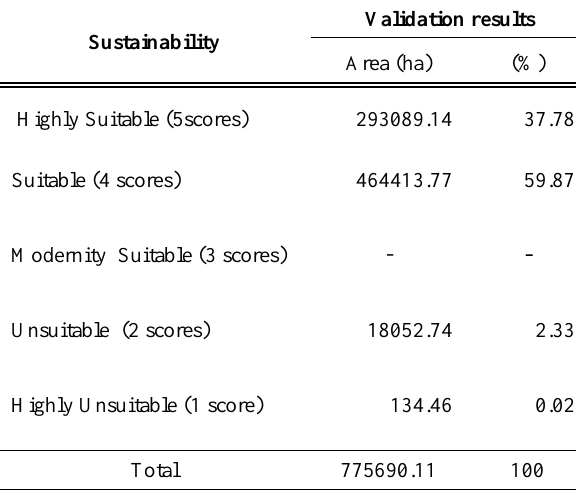
Table 8. Validation results of evaluated cropland suitability based on cadastre data of the current cropland area.